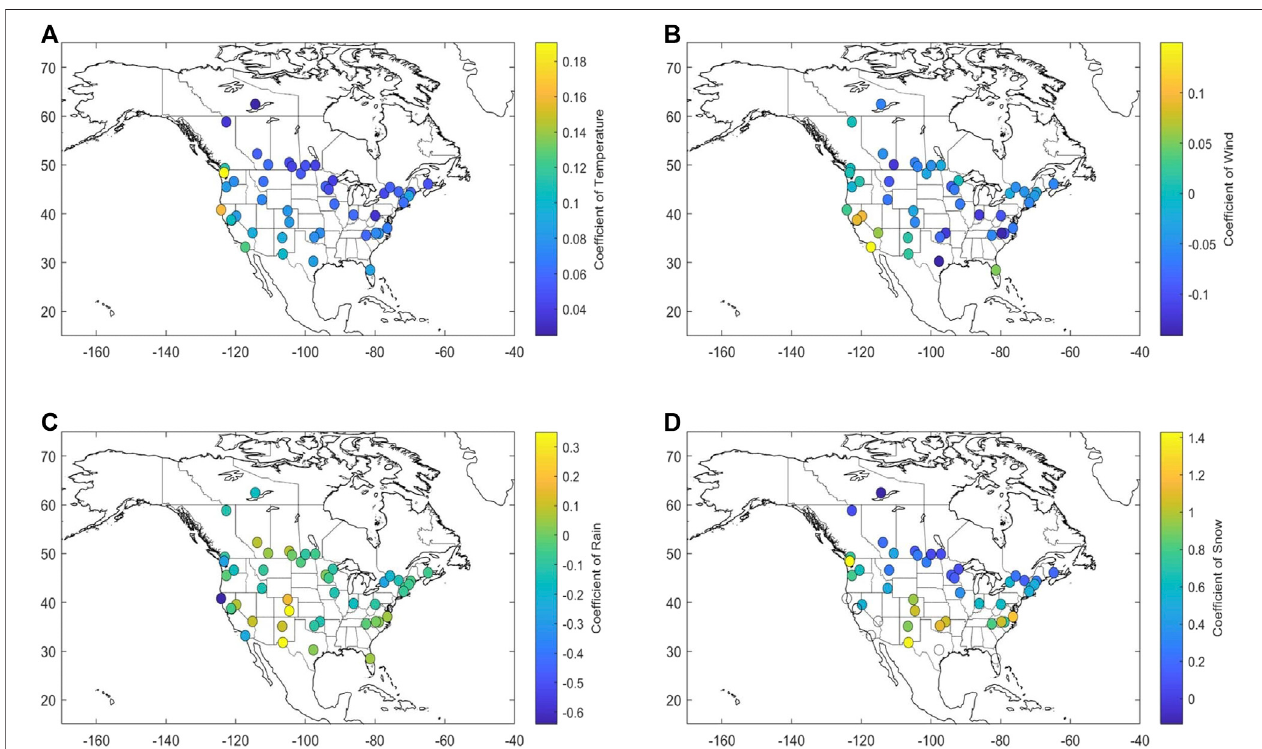
FIGURE 3 | Map of regression coef fi cient values from 47 MLR models for municipal water consumption: (A) coef fi cient that multiplies maximum temperature (b 1 ), (B) coef fi cient that multiplies wind speed (b 2 ), (C) coef fi cient that multiplies the binary variable for rain (b 3 ), and (D) coef fi cient that multiplies the binary variable for snow (b 4 ). The model is calibrated over the available observational record (at least 3 years within 1990 – 2018) for each city, yielding 47 sets of city-speci fi c regression coef fi cients.